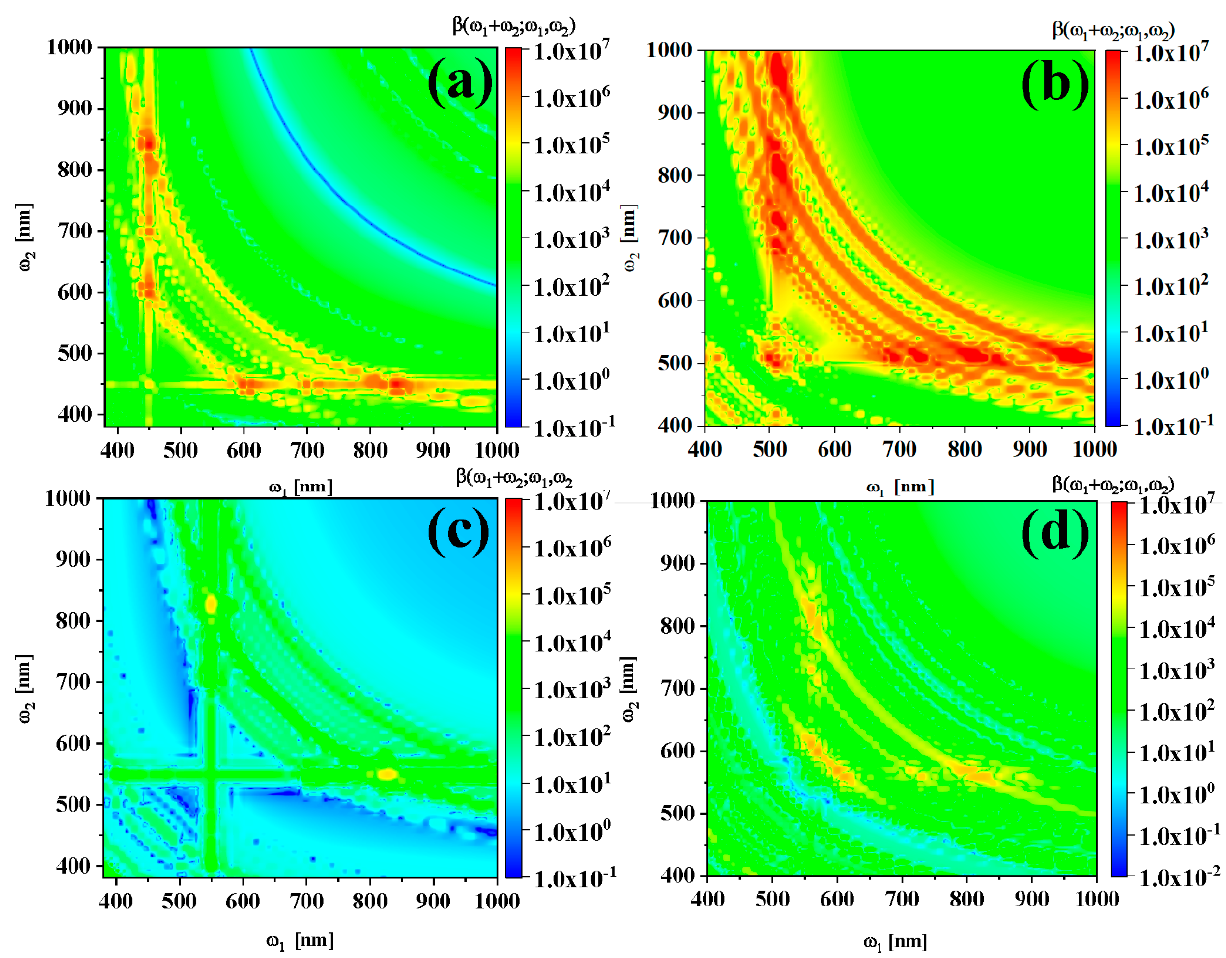
Figure 3. The sum-frequency coefficients of -H ( a ), -COOH ( b ), -CN ( c ) and -NO 2 ( d ) conjugated molecular